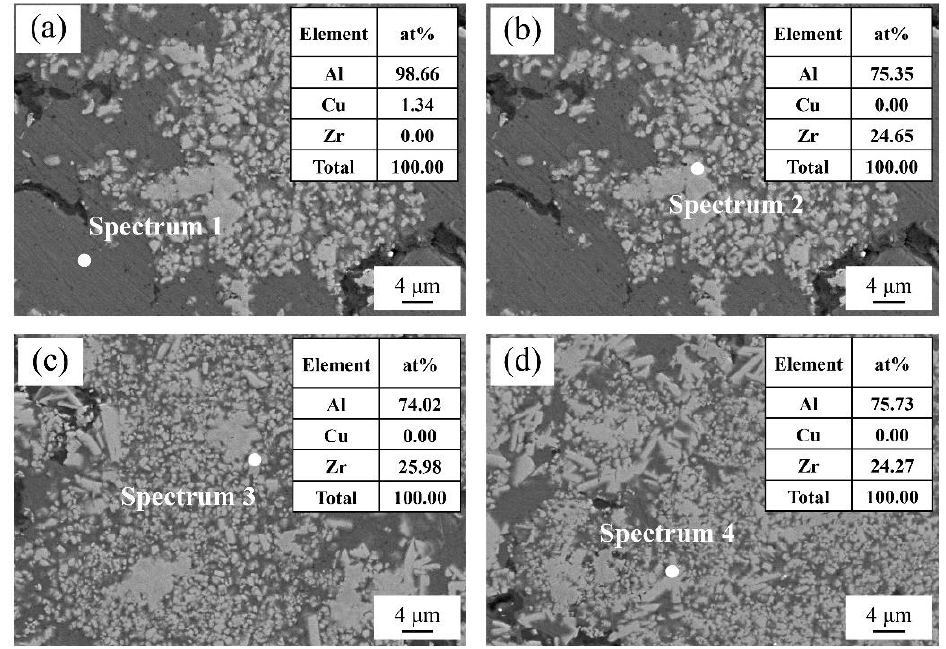
Figure 4. The points show the SEM images and results of EDS quantitative analysis of the Al 3 Zr/2024Al composites prepared with different Zr contents. ( a , b ) 10Zr; ( c ) 20Zr; ( d ) 30Zr. Figure 5 is the SEM image of the pore wall of Al 3 Zr/2024Al porous composites with different Zr contents (space holder content is 60 vol.%). With the increase of Zr content, the number of Al 3 Zr in the pore wall gradually increases, and the main components in the pore wall gradually change from 2024Al to Al 3 Zr. As shown in Figure 5a,b, the Al 3 Zr are mainly formed at the contact interface between Zr and 2024Al. In the region of the Al 3 Zr phase, the microstructure was more uniform and regular compared with other regions, and there are fewer defects in the reaction area. However, obvious powder gaps and defects can be found between the mechanically bonded 2024Al powder particles, there is an obvious gap between the 2024Al powders, and there is much unevenness in the pore wall. When the Zr content continues to increase, the defect and gap in the material are declined and the distribution of Al 3 Zr in the pore wall is more dispersed. In the case of Zr content 20 wt.%, the gap between 2024Al particles caused by mechanical bonding cannot be observed. It was supposed that the bonding mode of the material was metallurgical bonding. As the content of Zr further increases, a large number of 2024Al react with Zr. Almost the whole pore wall was occupied by Al 3 Zr particles. It demonstrates that the material is mainly Al 3 Zr. However, the amount of Al 3 Zr possibly causes serious brittleness in the samples. The qualitative relationship between the content of Al 3 Zr and the mechanical properties of the material will be investigated in the future.